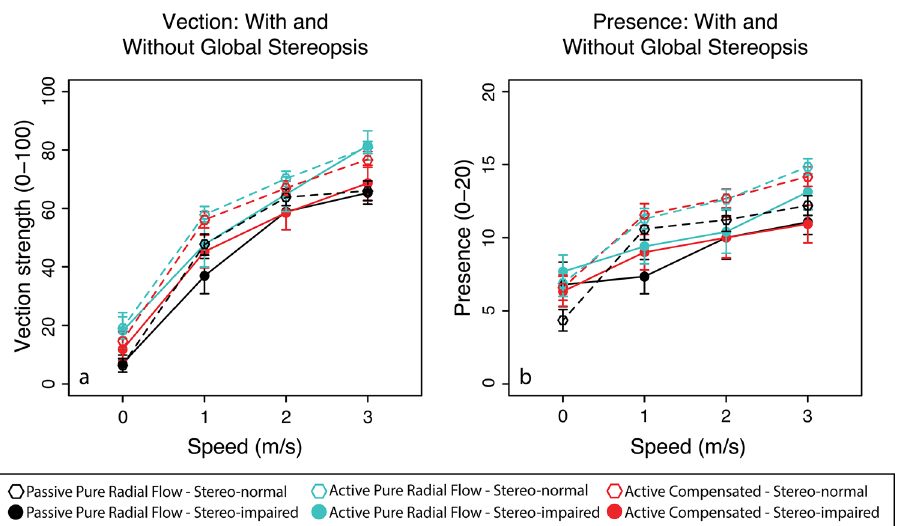
Figure 2. Mean vection strength ( a ) and spatial presence ( b ) scores plotted as function of simulated speed for each of the visual motion (passive radial, active radial and active compensation) and viewing conditions (with and without global stereopsis). Open symbols represent participants with global stereopsis while filled symbols represent those without global stereopsis. Error bars show standard error of the mean. N =